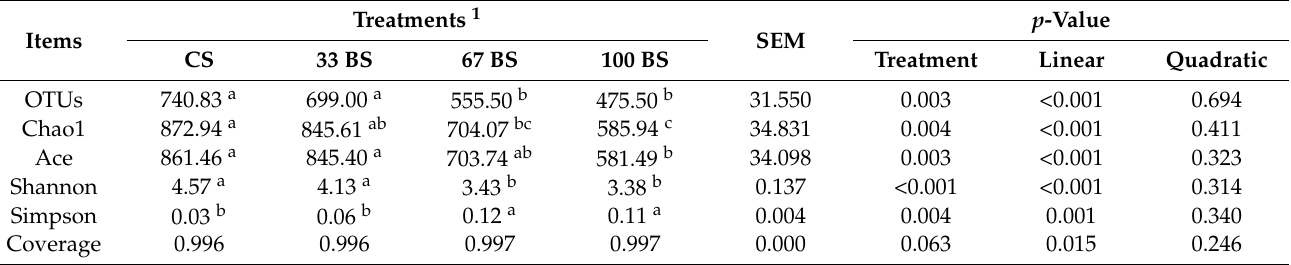
Table 4. Analysis of α -diversity at 2 h after morning feeding among different treatment groups.